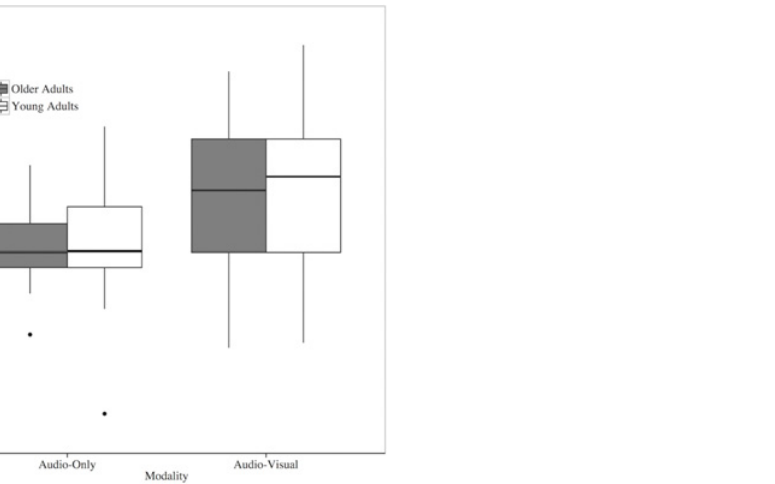
Fig 5. Relative meaningful benefit of younger and older adults across audio-only and audio-visual presentation modalities at -12 SNR. Bars represent upper and lower limits of the sample data, box limits represent upper and lower quartile, and the heavy line represents the sample median. Circles indicate